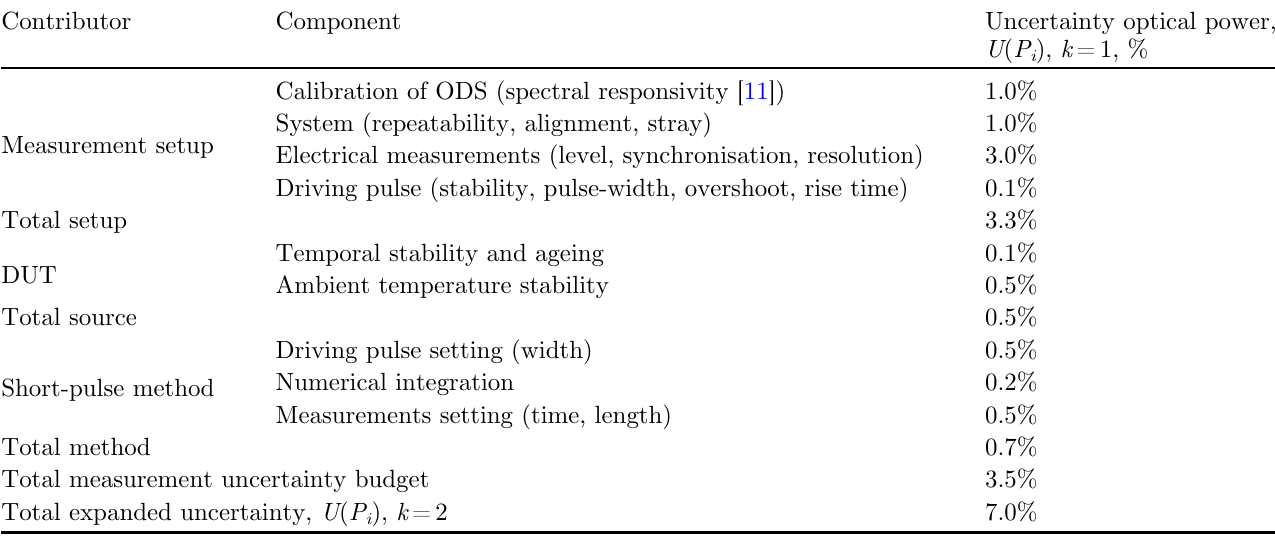
Table 8. Uncertainty budget components for short-pulse driven DUT.